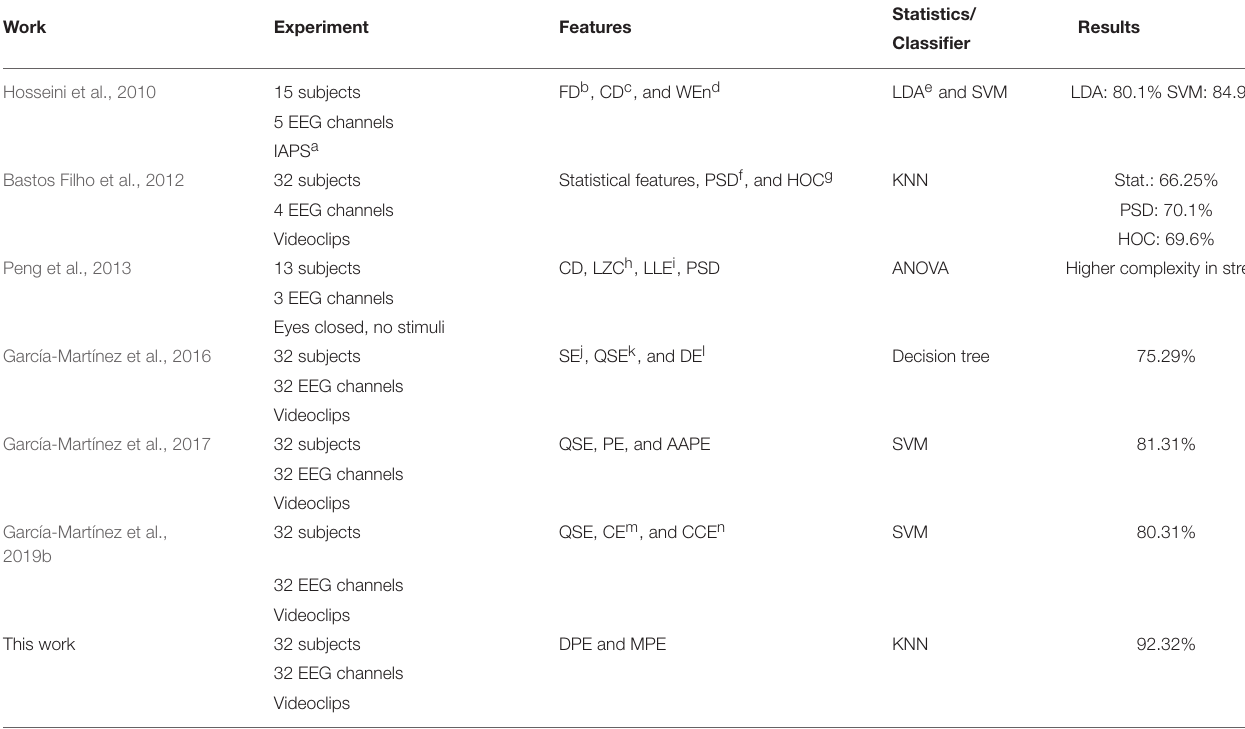
TABLE 5 | Comparison of the most relevant works dealing with automatic identification of negative stress from the